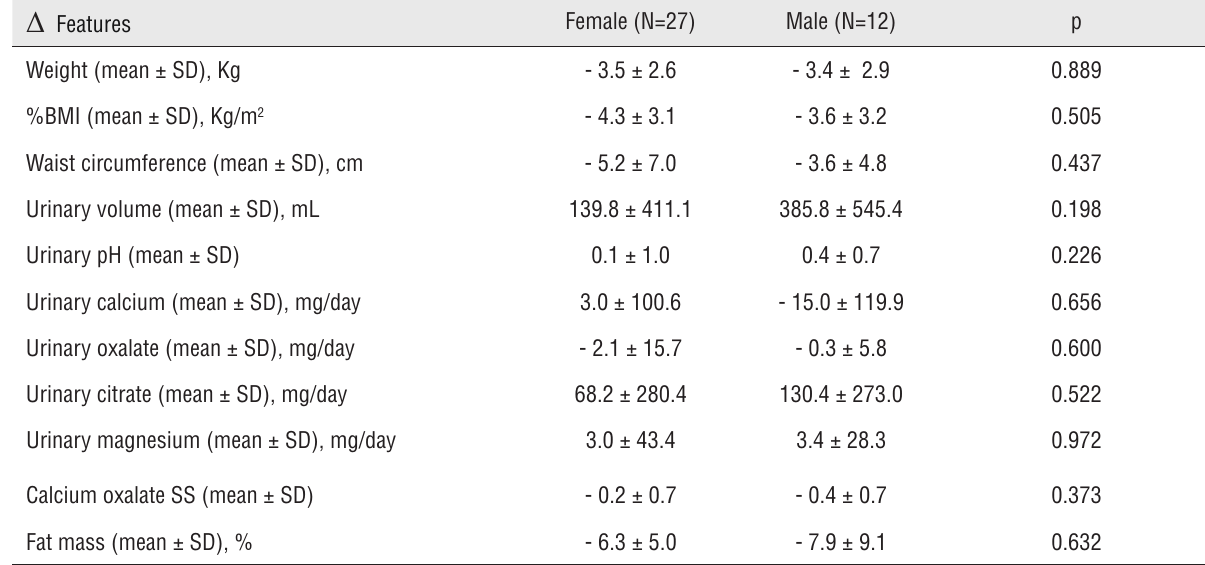
Supplementary Table 4 - Comparison of variations of 24-hour urinary lithogenic parameters after low calorie diet between genders. Δ